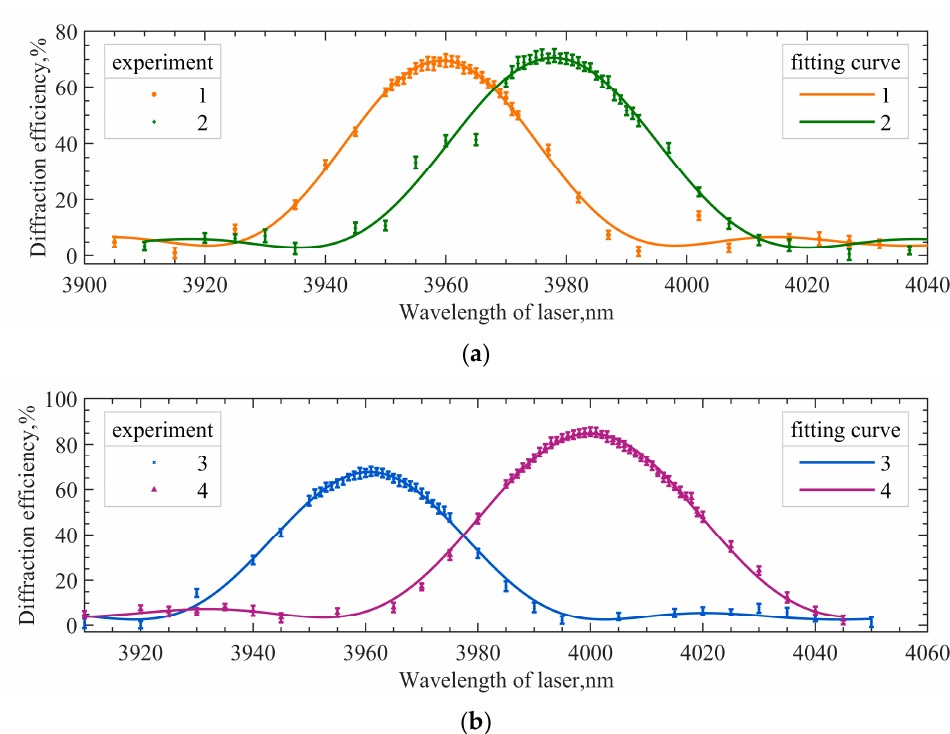
Figure 6. Spectral responses at some different incident angles. ( a ) 1: θ p = 0 ◦ ; 2: θ p = − 3 ◦ ; ( b ) 3: θ p = − 1 ◦ ; 4: θ p = − 4 ◦ .